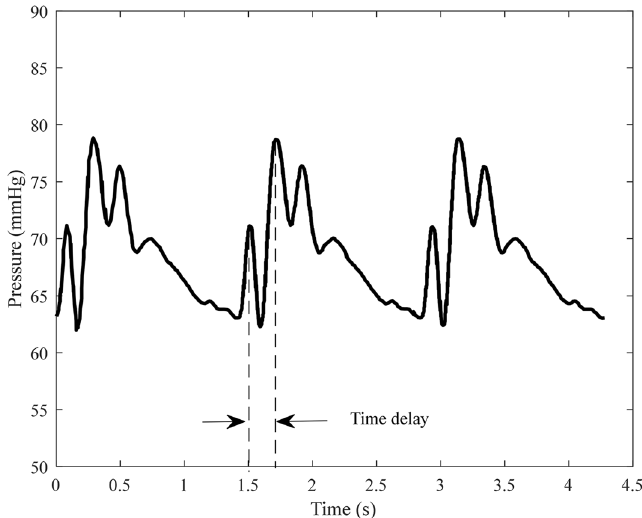
Figure 9. Backward wave calculated from the measured flow wave and pulse